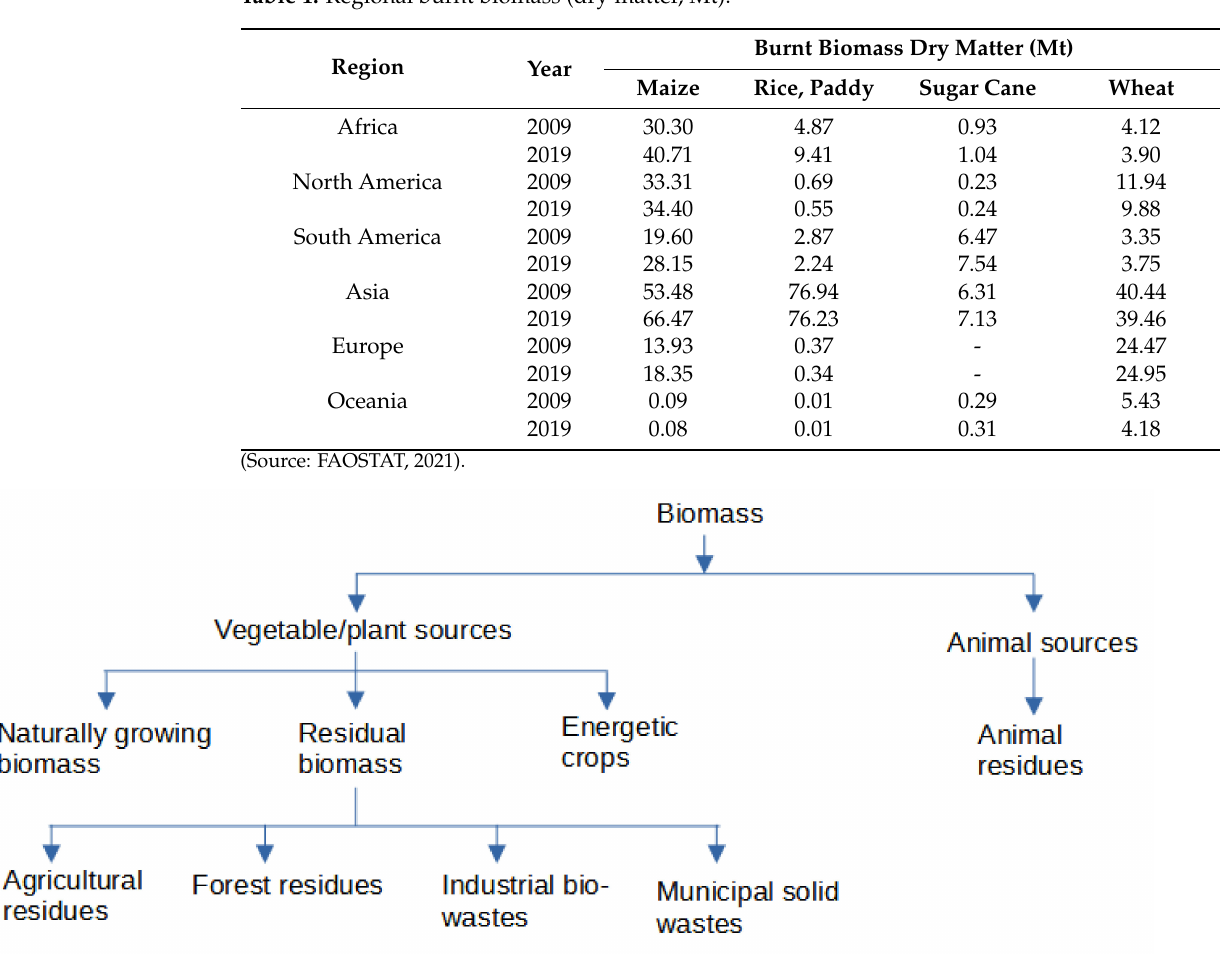
Figure 4. Classification of biomass based on the origin (adapted from